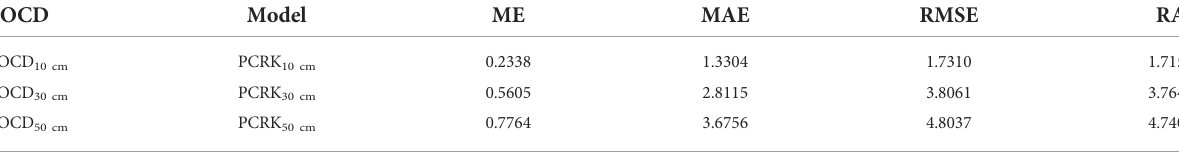
TABLE 4 Veri fi ed accuracy of the principal component regression kriging